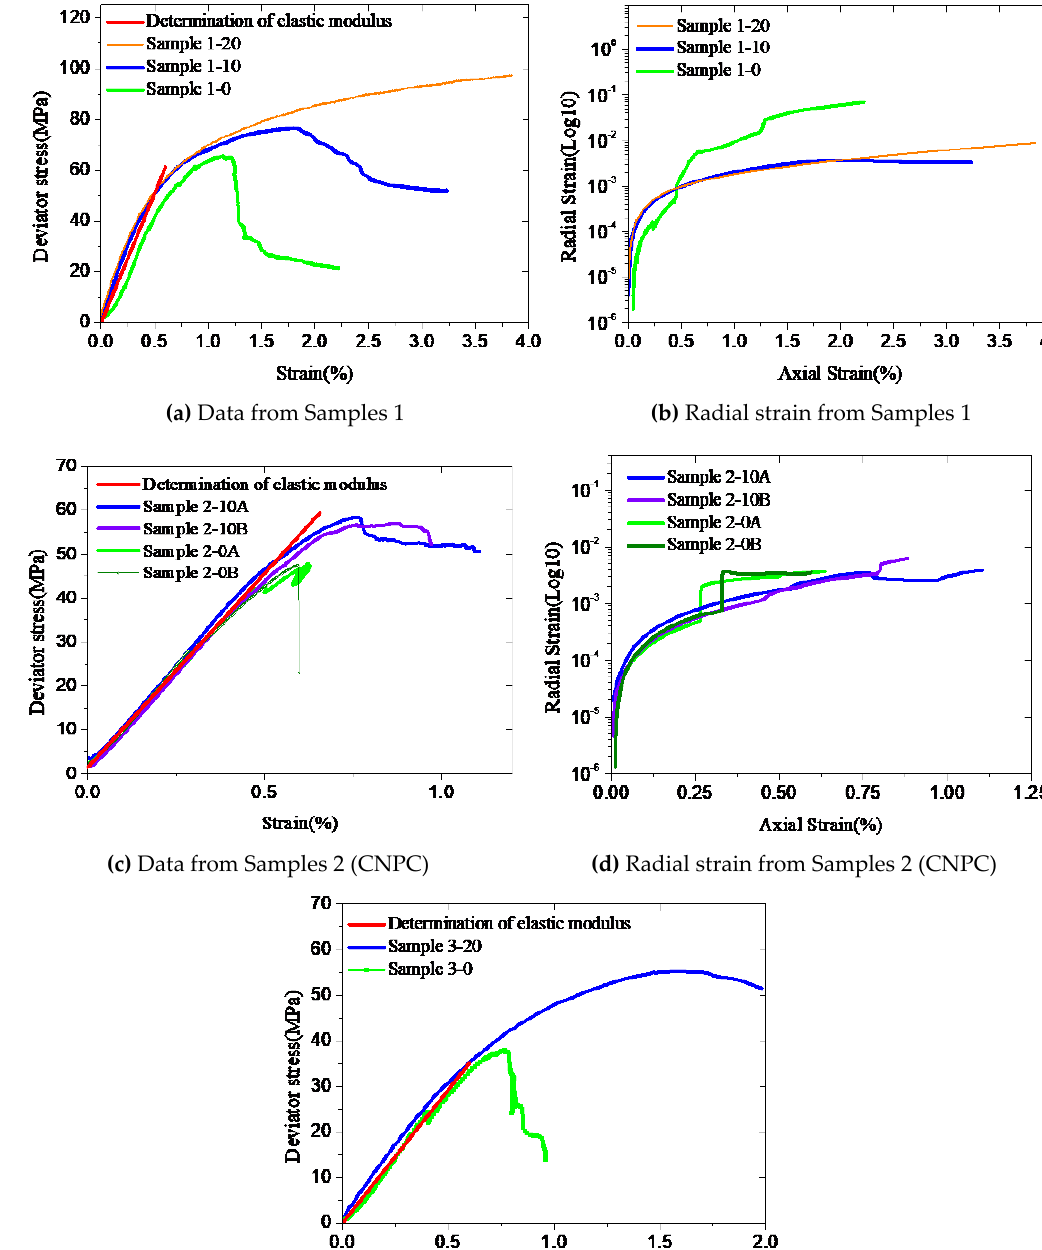
Figure 3. Determination of elastic modulus from test measurements ( a-e ).